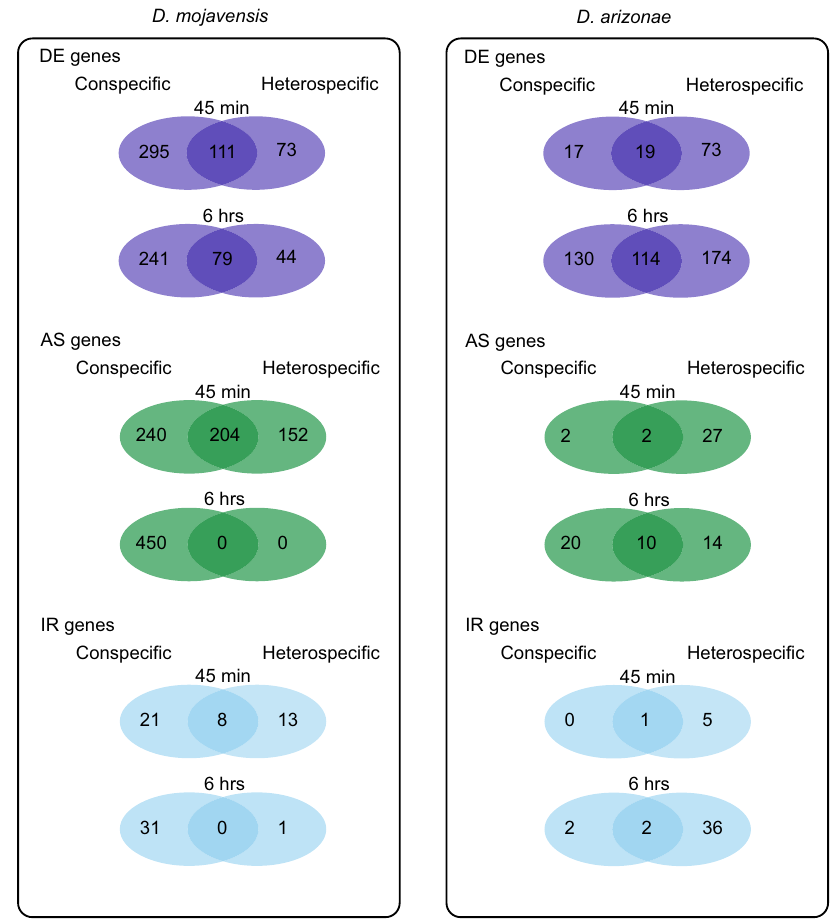
Fig. 6 Comparison of differentially regulated genes in conspeci fi c and heterospeci fi c crosses in D. mojavensis and D. arizonae . Overlapping genes represent conspeci fi c mating responsive genes that were properly regulated in heterospeci fi c crosses. Genes unique to the conspeci fi c cross represent conspeci fi c mating responsive genes that were misregulated in heterospeci fi c crosses. Genes unique to the heterospeci fi c cross are those that are not part of the normal conspeci fi c mating response but had disrupted transcriptional pro fi les in the heterospeci fi c cross ( “ heterospeci fi c only ”